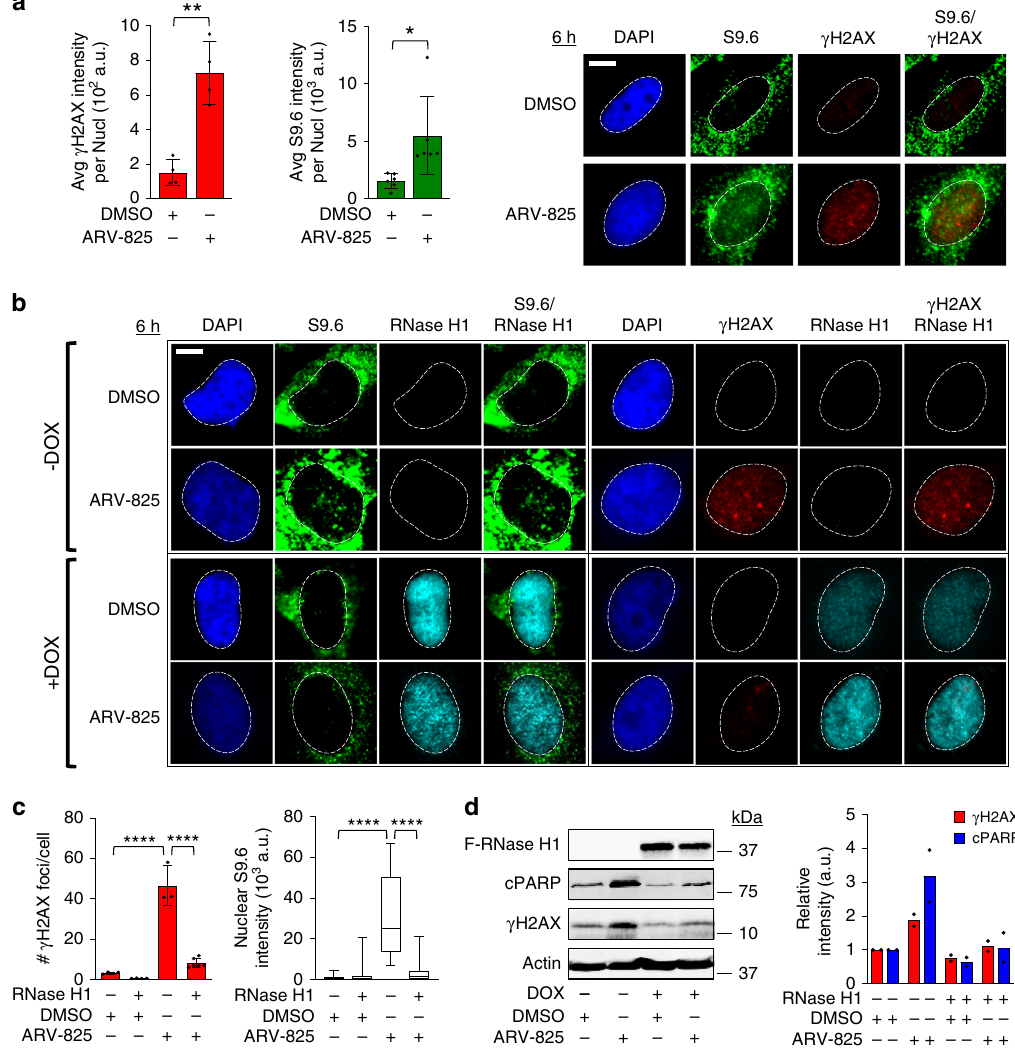
Fig. 3 DNA damage caused by BRD4 loss requires R-loop accumulation. a Quanti fi cation and representative IF images of nuclear S9.6 and γ H2AX intensity in HeLa cells following treatment with ARV-825 (100 nM for 6 h). Quanti fi cation was performed as described in Fig. 1a. For speci fi c quanti fi cation of nuclear S9.6 staining, regions of interest were overlaid on the DAPI signal (delineated by dotted white lines in the fi gures) and selectively quanti fi ed to exclude cytoplasmic S9.6 signal and nucleolar S9.6 signal ( n = 3 independent experiments). Statistical signi fi cance assessed using two-tailed unpaired t test ( γ H2AX P = 0.0010; S9.6 P = 0.0186). b , c Representative IF images and quanti fi cation of nuclear S9.6 intensity, DMSO vs ARV-825 ** DMSO vs ARV-825 * γ H2AX foci, and RNase H1 in HeLa cells in the absence ( − DOX) or presence ( + DOX) of doxycycline-induced FLAG-tagged RNase H1 expression for 24 h, followed by treatment with 100 nM ARV-825 for 6 h ( n = 3 independent experiments). Box-whisker plots are drawn as in Fig. 1b. Signi fi cance assessed using ANOVA followed by Tukey ’ s test ****Adjusted P < 0.0001. d Lysates from cells treated as in panel B were assayed for FLAG-tagged RNase H1, γ H2AX and cPARP expression by WB. Quanti fi cation of γ H2AX and cPARP intensity, data presented as mean ( n = 2 independent experiments). In panels a and c data are presented as mean ± SEM. Scale bars = 2.5 μ m. Source data are provided as a Source data fi processes of R-loop removal are affected (i.e. loss of RNase-H inhibitor ZVAD-FMK. As shown in Fig. 6a, treatment of cells function) 9 , DNA damage appears to occur at only a fraction of with 1 µM JQ1 alone for 8 h still results in pan-nuclear γ H2AX these sites 34 . This, coupled with other observations that the foci (Fig. 6a, JQ1), while co-treatment of cells with JQ1 and persistence of a subset of R-loops can impair the expression of ZVAD-FMK eliminates the faint diffuse γ H2AX background, and speci fi c genes 35 – 37 led us to examine whether a subset of R-loops results in fewer but brighter, more well-de fi ned γ H2AX foci, is responsible for the DNA damage foci observed upon BRD4 without signi fi cantly affecting the S9.6 staining (Fig. 6a, JQ1 + inhibition in cells. To address this, cells were co-stained for ZVAD). This supports that a speci fi c subset of R-loops is asso- γ H2AX and DNA-RNA hybrids using the S9.6 monoclonal ciated with DNA damage foci (Fig. 6b, i – iv), suggesting that not antibody. Importantly, because prolonged bromodomain inhibi- every R-loop causes DNA damage following BRD4 inhibition. tion results in pan-nuclear γ H2AX foci on a faint diffuse γ H2AX staining background, likely as a consequence of apoptosis (Fig. 1a, f), we reduced the treatment time and used a slightly higher amount of JQ1 (1 µM) in combination with the pan-caspase